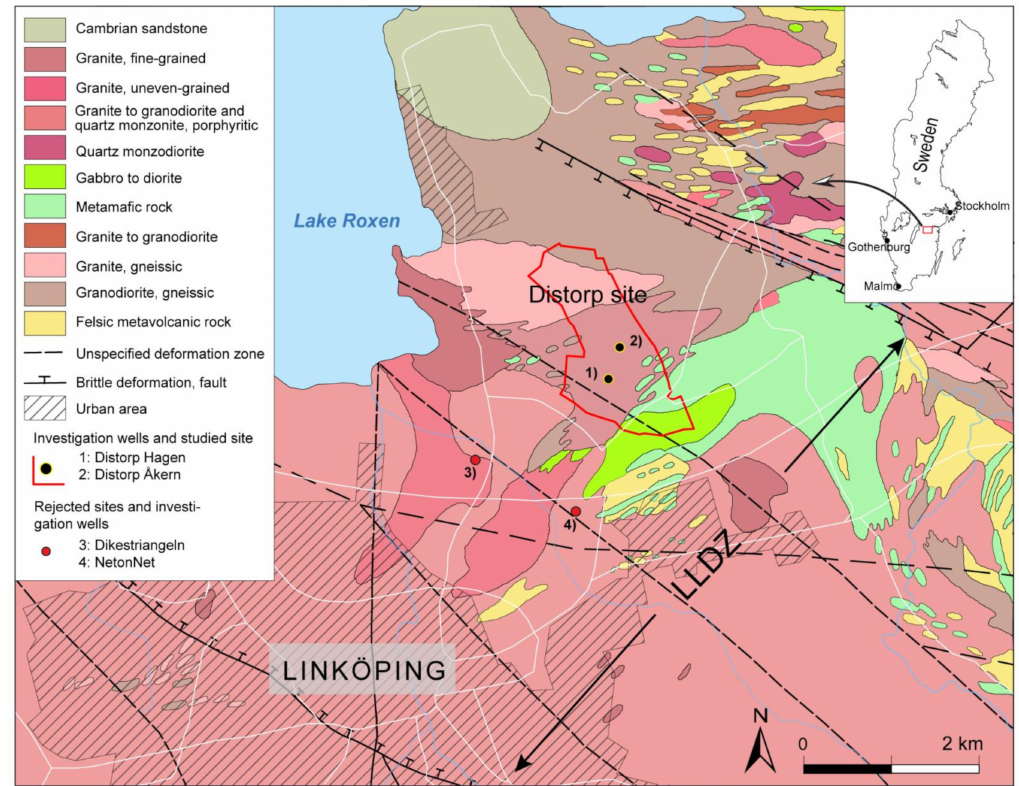
Figure 1. Bedrock geological map of the Distorp site (red frame) and surroundings extracted from the Geological Survey of Sweden’s bedrock database. LLDZ, Loftahammar–Linköping deformation zone. Map modified with permission after [18]. © Sveriges geologiska